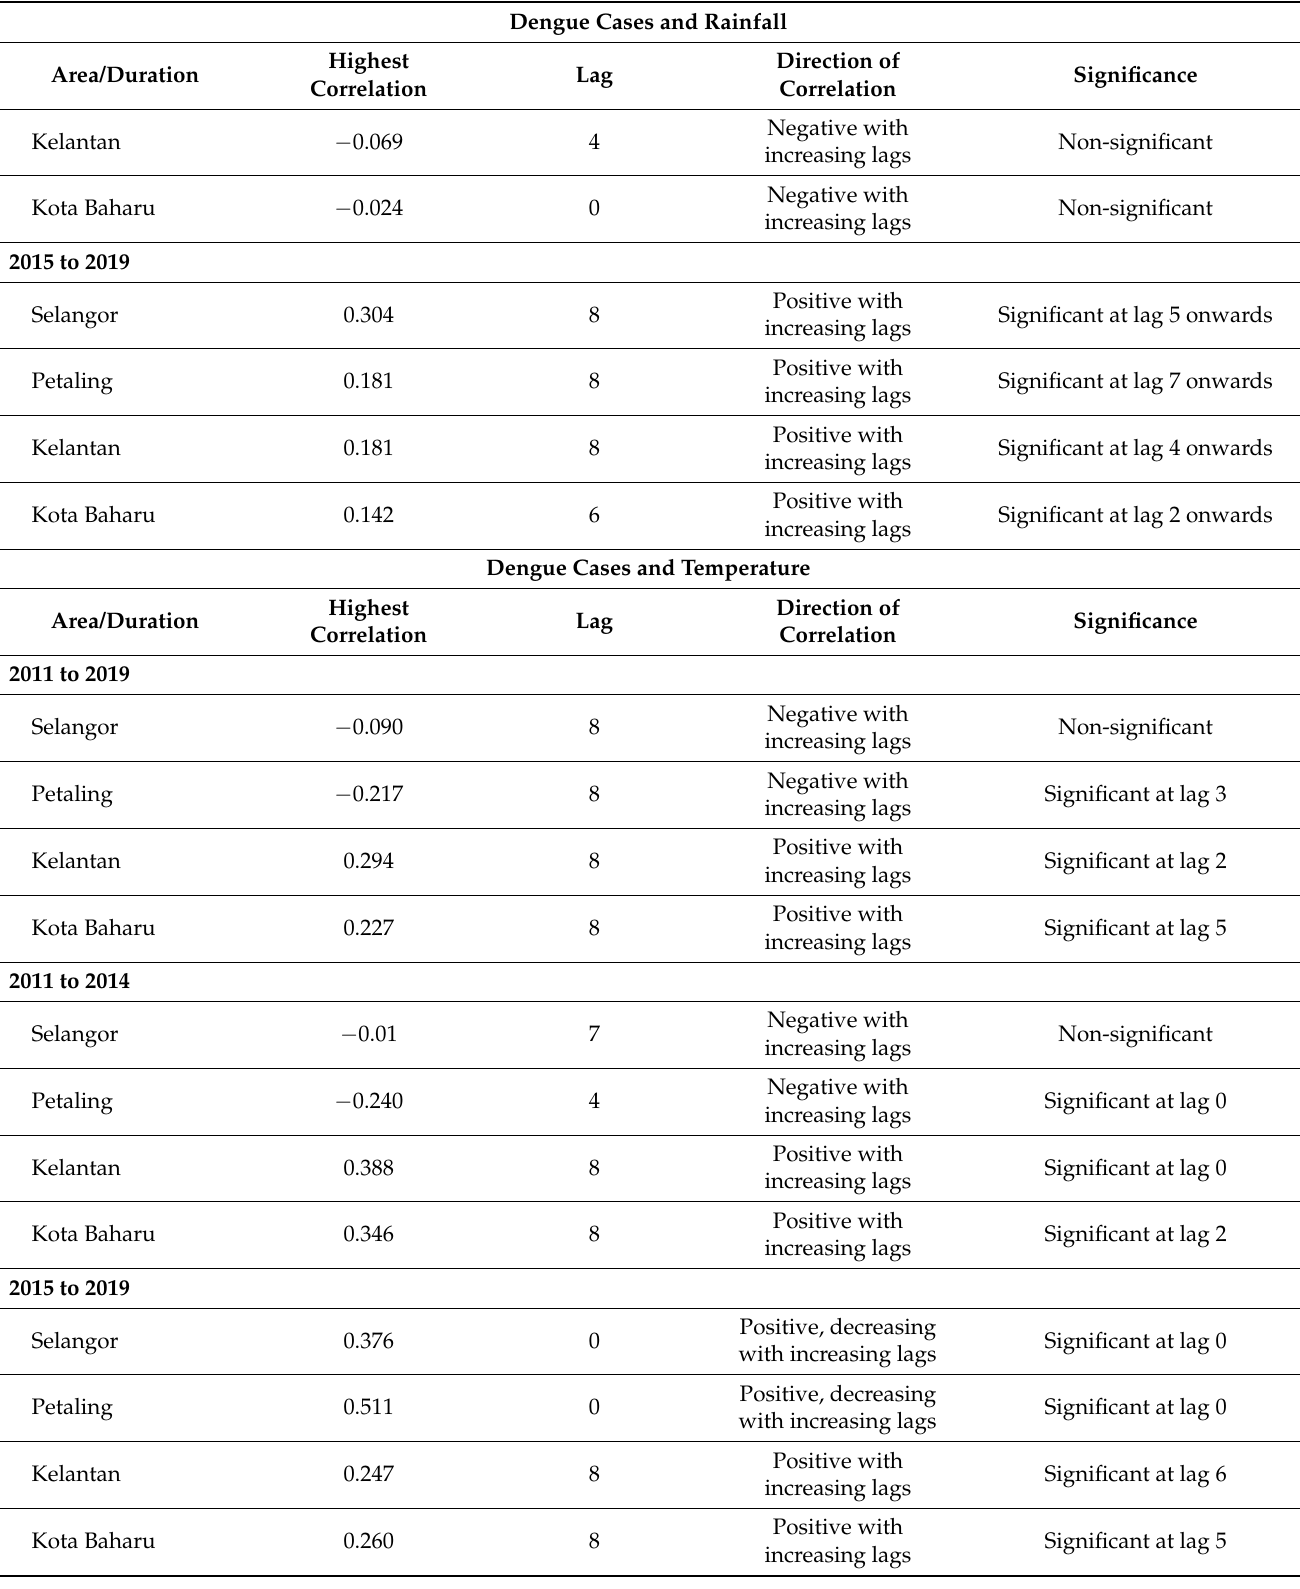
Table 3. Cont. Dengue Cases and